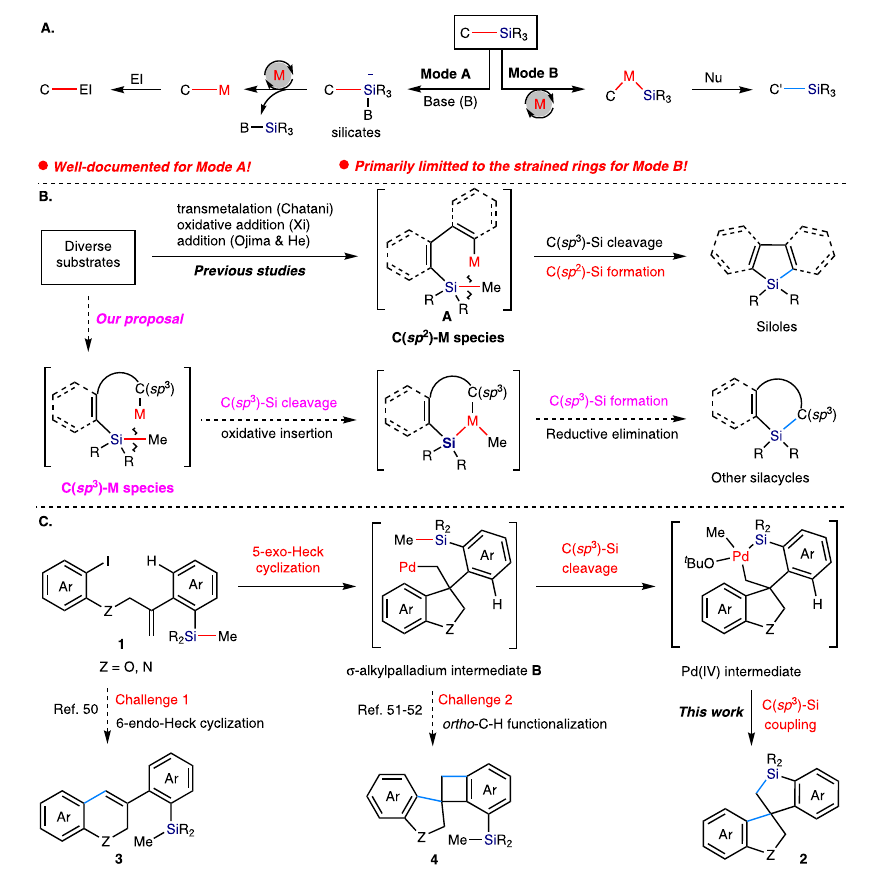
Fig.1|CurrentstateandourstudyforunstrainedSi − C(sp 3 )bondactiviationby transition metal insertion. A Two general activation modes for C – Si bond clea- vage in transition metal catalysis. B Literatures and our proposal on unstrained